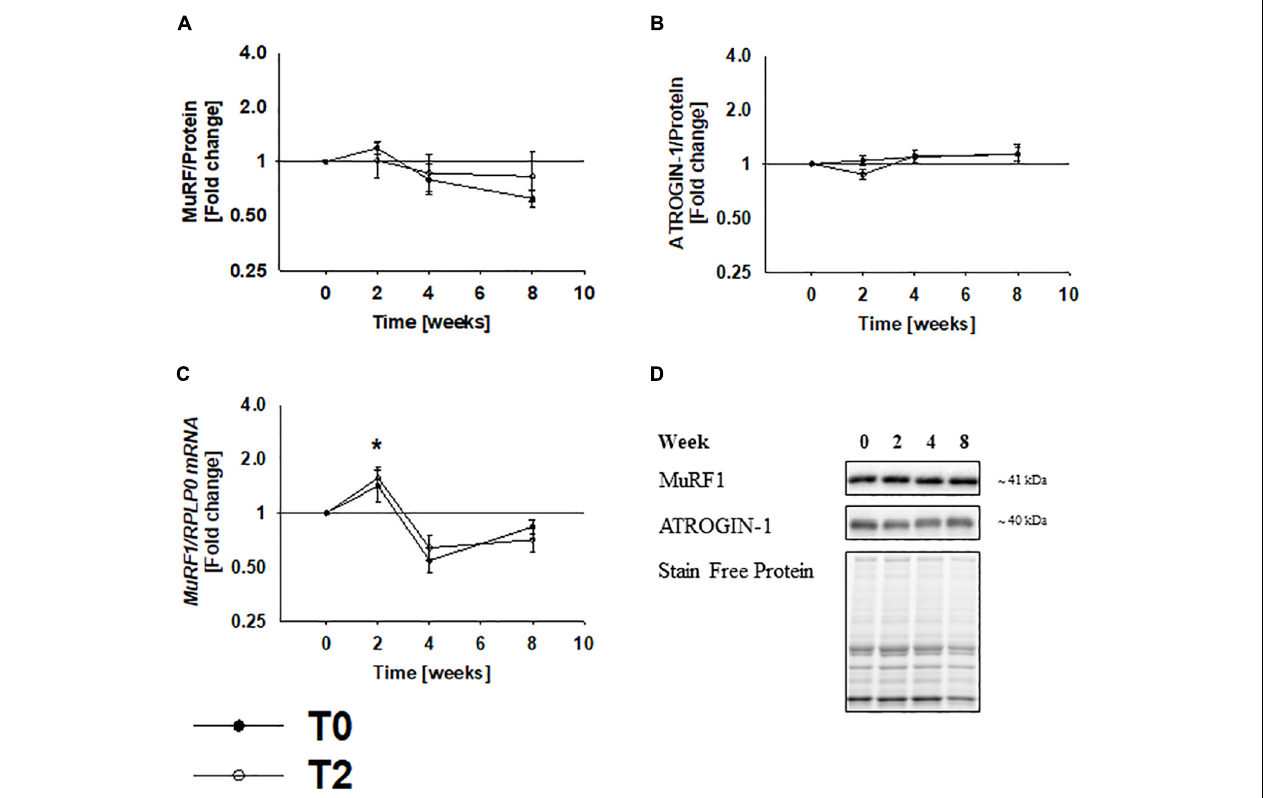
FIGURE 3 | Protein expression of muscle-specific E3-ligases did not change during immobilization. MuRF1 and ATROGIN-1 protein expression did not change during immobilization and rehabilitation (A,B) . mRNA expression of MuRF1 increased during immobilization and decreased during the first 2 weeks of rehabilitation (C) . Values are geometric means ± back-transformed SE. ∗ Post hoc test showed significant change during immobilization. Representative western blots (D) . Based on the applied molecular standards, approximated molecular weights are indicated on the right. Filled symbols represent subjects from T0 and open symbols represent subjects from